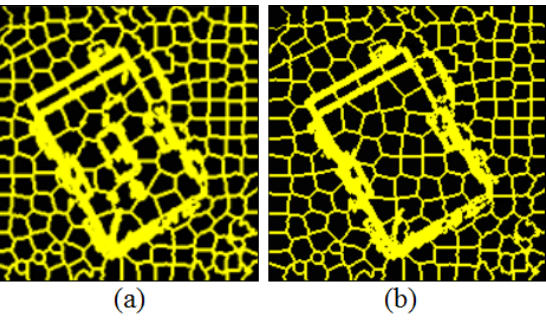
Figure 7. ESLIC on the pan-sharpened image ( a ), ESLIC on the mean-image generated using the integrated superpixels on the object core ( b